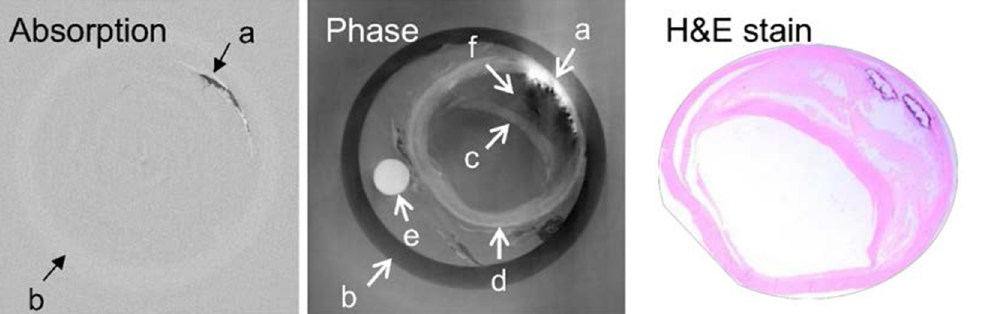
Fig 1. Improved soft-tissue contrast afforded by X-ray phase images: An iliac artery with extensive atherosclerotic disease demonstrating different plaque components in the phase but not attenuation image a: calcification; b: plastic container; c: fibrous cap; d: tri-laminar arterial wall; e: a plastic rod as fiducial marker; f: soft plaque or atheroma.